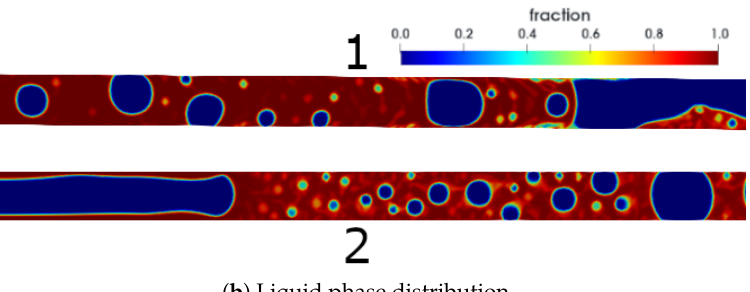
Figure 18. Numerical results of the Kafeel and Turan model [28] model in 0.5 s for 75 W input power.